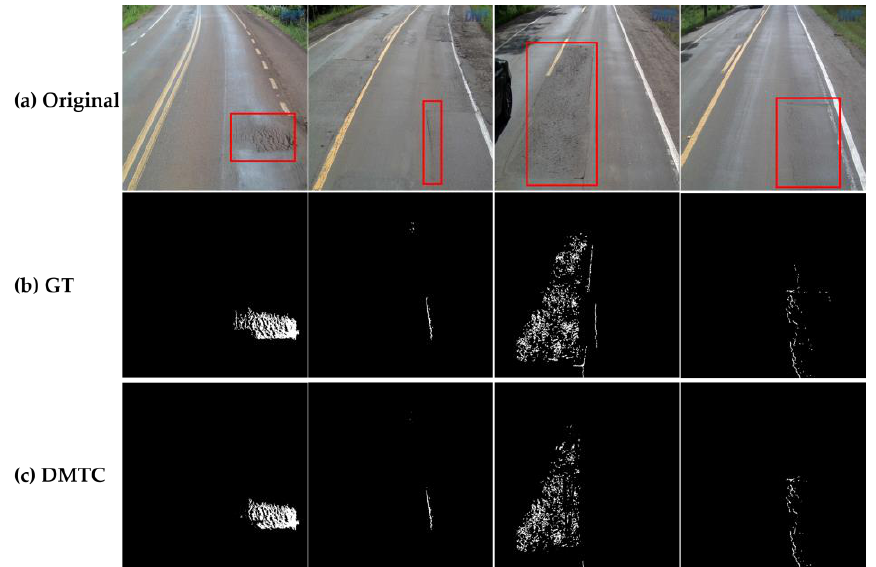
Figure 12. Visualization of partial crack segmentation results in the CPRID dataset. It includes the segmentation results of small, medium and large cracks. There is a red outline around the pits in the original image.